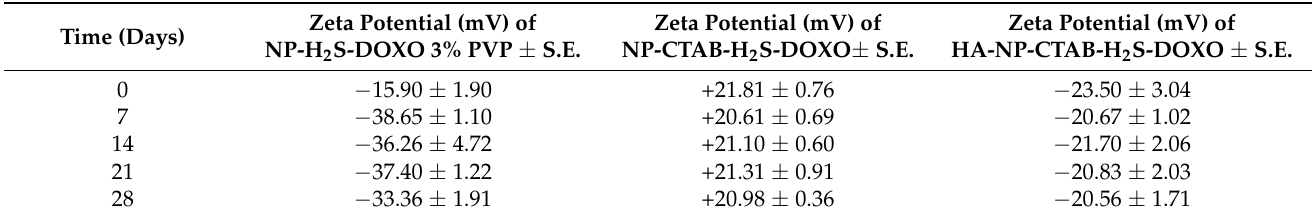
Table 8. Zeta potential of NP-H 2 S-DOXO 3% PVP, NP-CTAB-H 2 S-DOXO, and HA-NP-CTAB-H 2 S- DOXO over time (28 days).